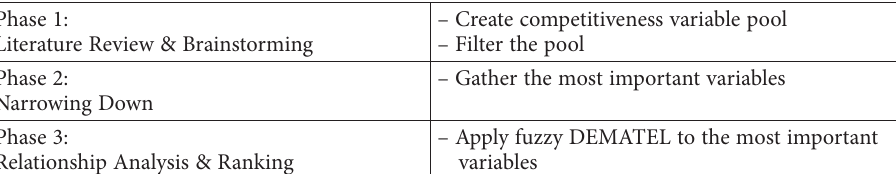
Table 2. Outline of the proposed hybrid